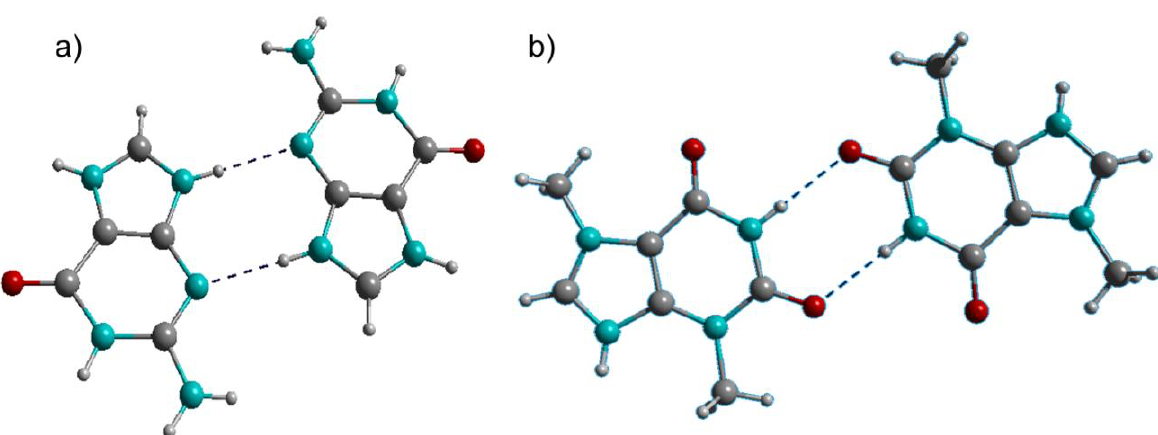
Figure 1. ( a ) Guaninium dimer; ( b ) Theobrominium dimer. C: grey, H: white, N: turquoise, O: red. This color scheme is also used in subsequent figures.